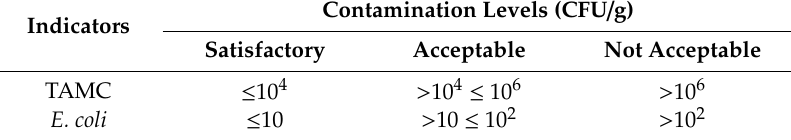
Table 1. Satisfactory, acceptable and not acceptable total aerobic mesophilic count (TAMC) and E. coli contamination levels (colony forming units per gram) for ready-to-eat leafy green salads according to Portuguese guidelines